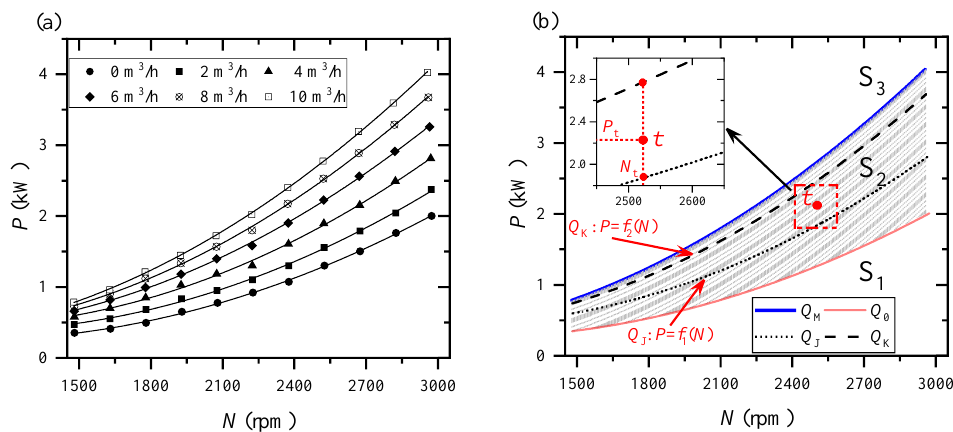
Figure 6. PN curves and PN curves interpolation methods: ( a ) PN curves for different flow rates and ( b ) PN curve-based flow estimation method.